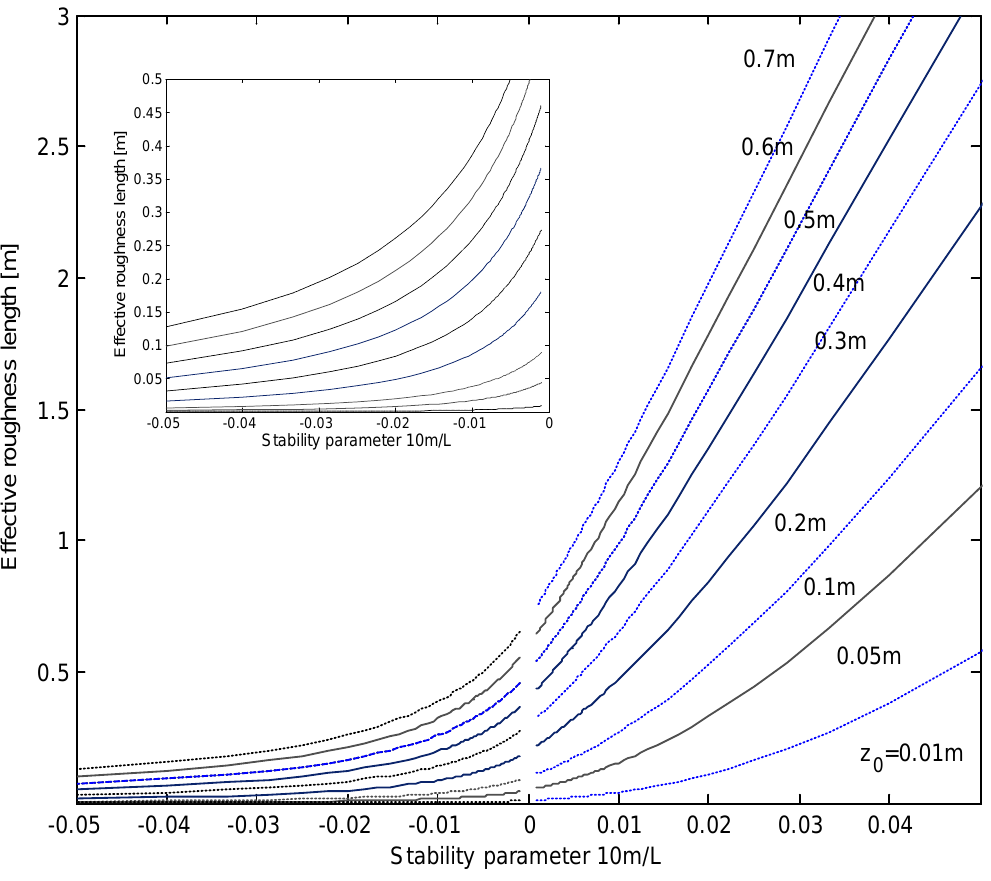
Figure 13. Effective or apparent roughness length as a function of the stability parameter 10 m/ L for different values of the true roughness length, both under stable and unstable conditions. Inset : Magnified portion of the negative range of 10 m/ L (unstable